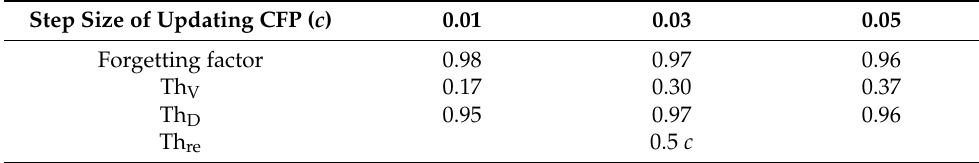
Table 1. Typical selection of parameters and thresholds.